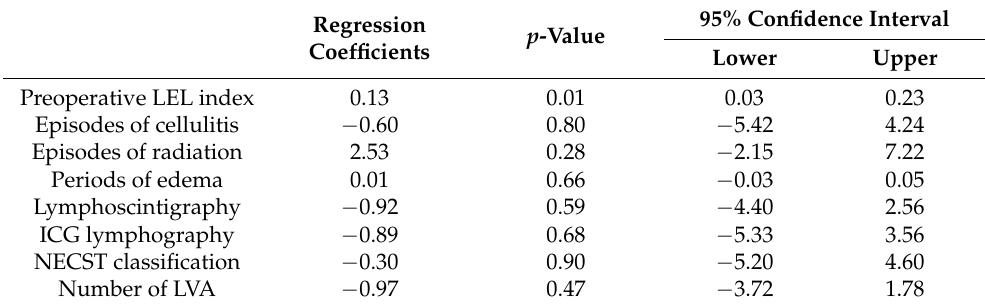
Figure 6. Correlation between the results of the first lymphatic venous anastomosis (LVA) and clinical parameters. Rate of improvement (RI) after the first LVA and preoperative lower extremity lymphedema (LEL) index exhibited moderate positive correlations (r = 0.42, p < 0.05) ( A ). However, RI after the first LVA was not correlated with any stage of normal, ectasis, contraction, and sclerosis type classification (NECST) ( B ), lymphoscintigraphy ( C ), or indocyanine green (ICG) lymphography ( D ). Table 2. The multiple regression analysis of factors related to the ratio of improvement after the first LVA.